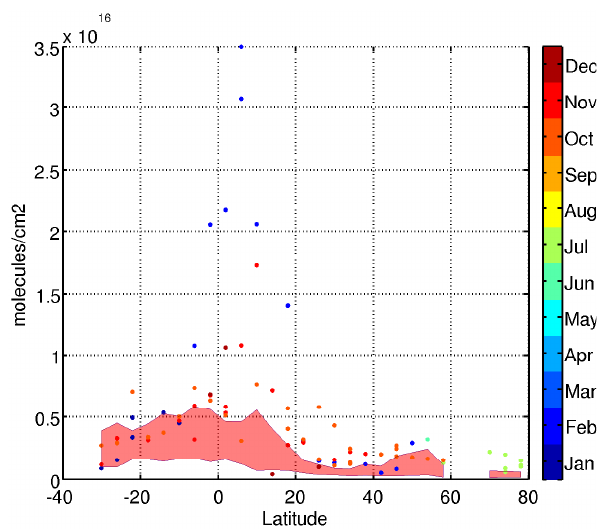
Fig. 5. Monthly FA total column measured during cruises in the Atlantic ocean in 1996, 1999, 2000, 2002, 2003 and 2005 (dots). The 2004–2008 model monthly mean range is indicated by the red shaded area. FA maximum in the tropics reflects biomass and bio- genic sources.